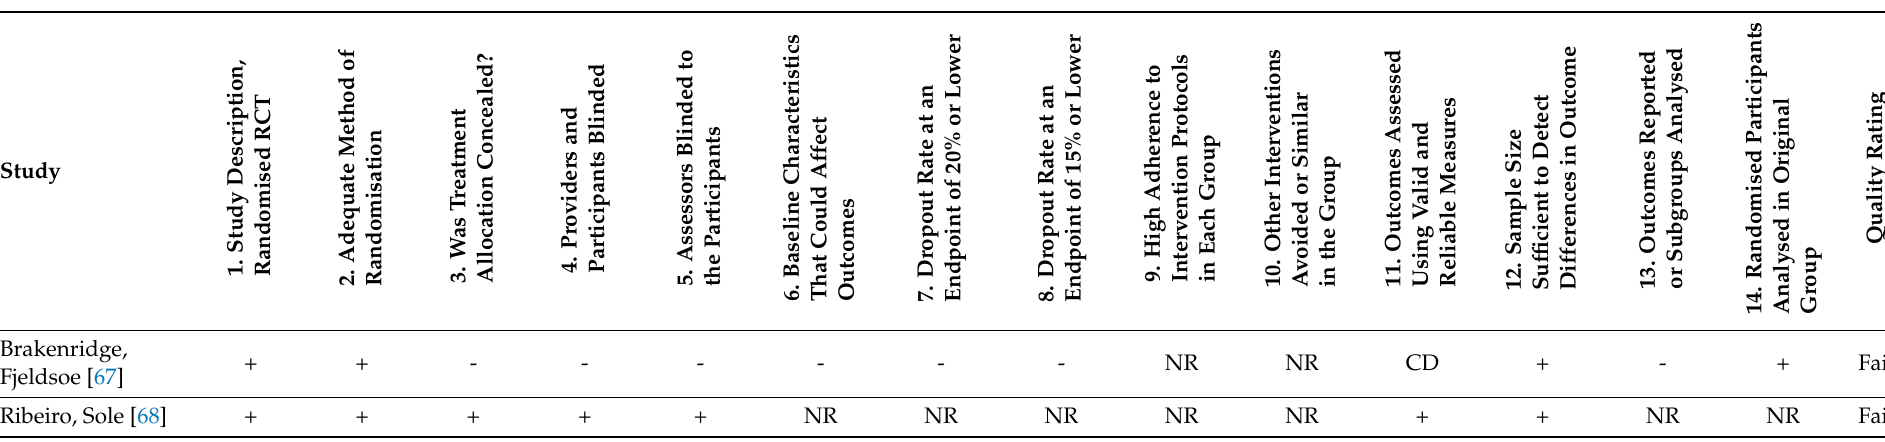
Table 6. Risk-of-bias evaluation for randomised controlled trials ( n = 2) using the National Institutes of Health risk-of-bias tool for controlled intervention studies.